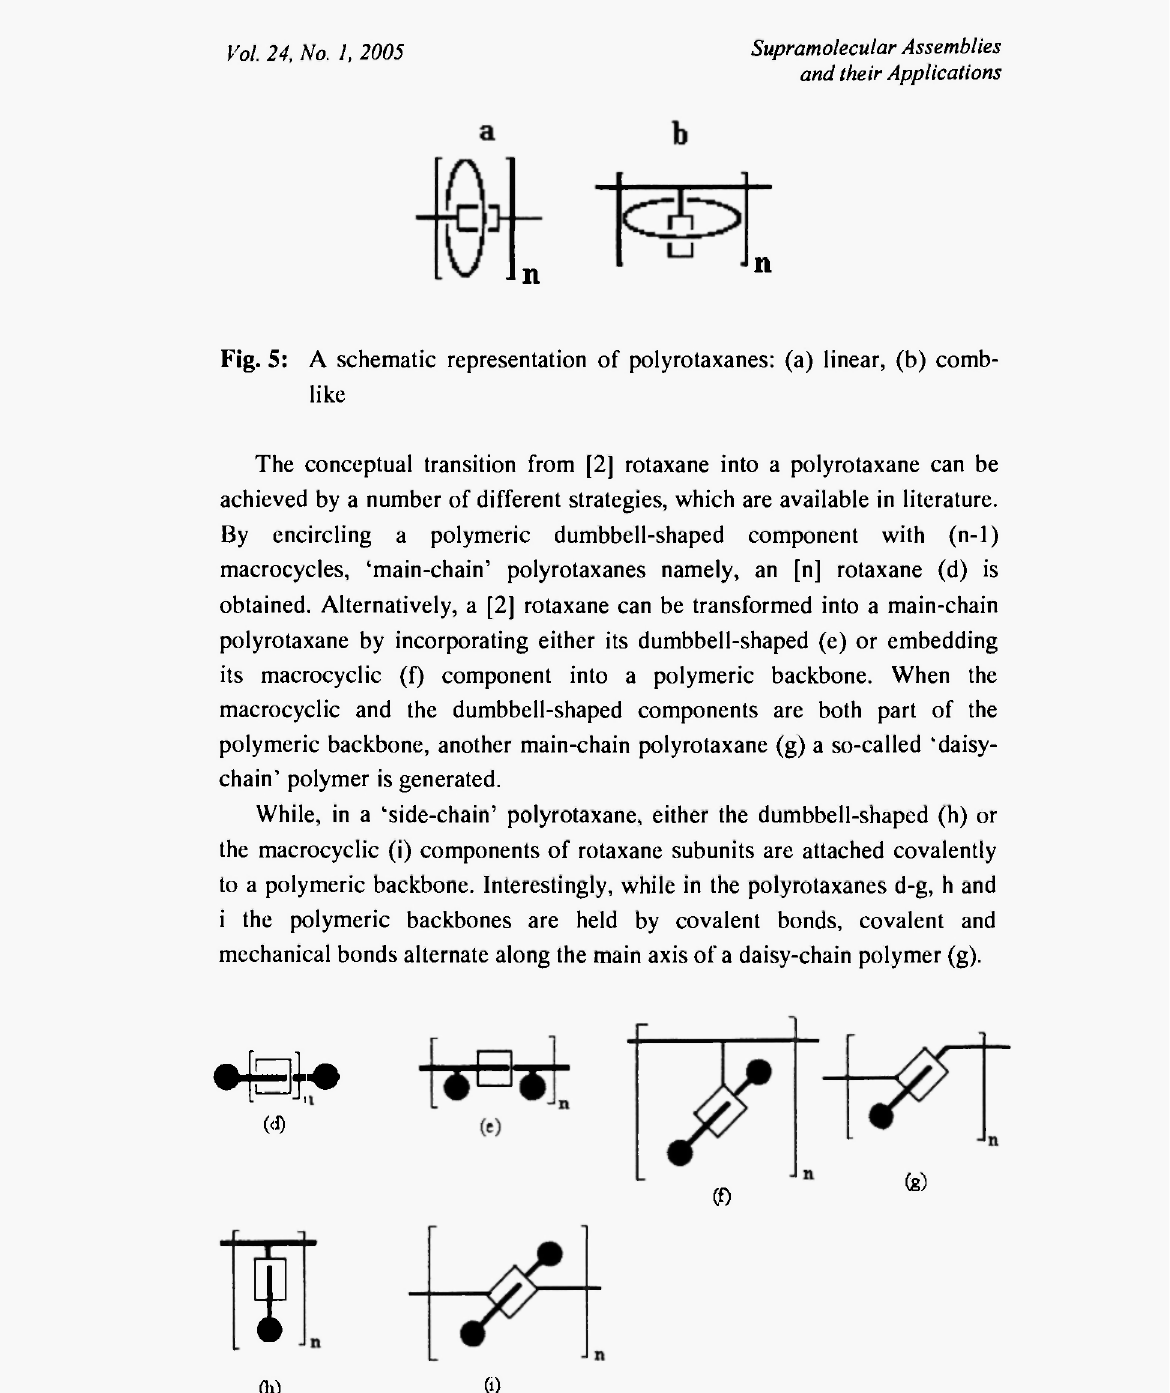
Fig 6: Types of main-chain (d-g) and side-chain (h-i)